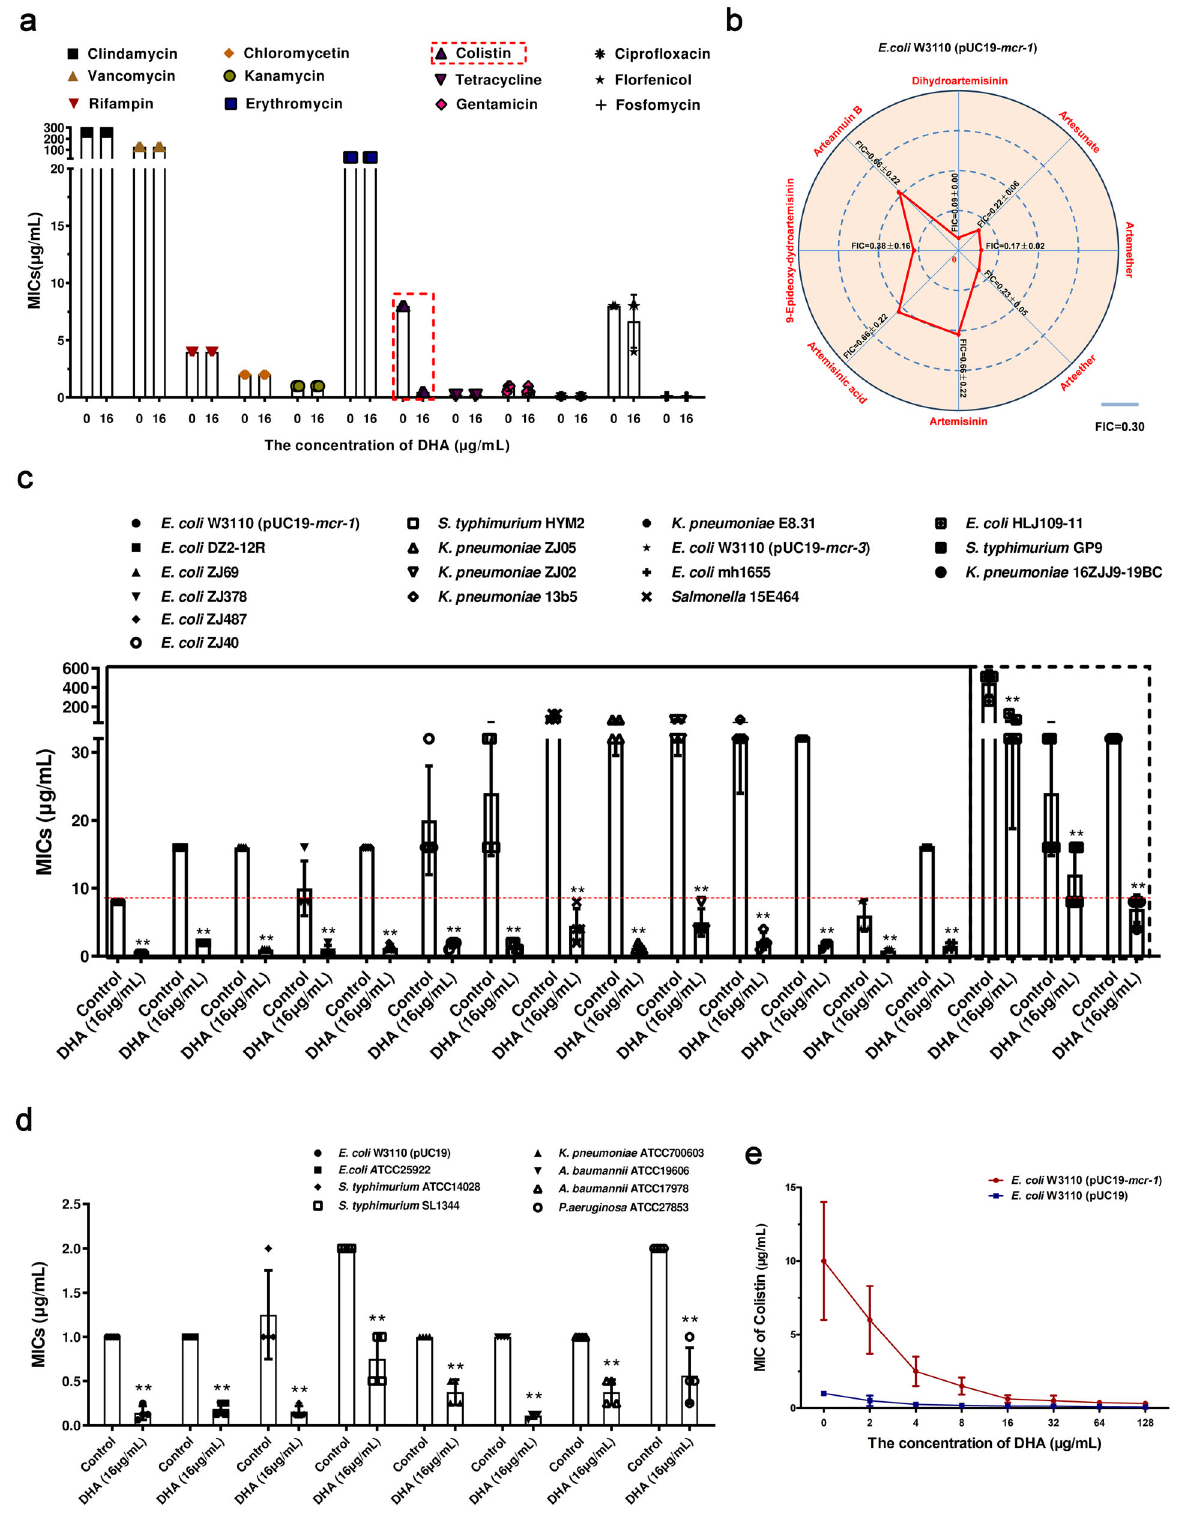
Fig. 1 DHA restores the antibacterial activity of colistin. a DHA (16 μ g/mL) only had a signi fi cant synergistic effect with colistin (outlined in red) among 12 different antibiotics against E. coli W3110 (pUC19- mcr-1 ) ( n = 3). b Contribution capacity chart of FIC showing that artemisinin derivatives such as artesunate, artemether, arteether and 9-epideoxy-dydroartemisinin also had a signi fi cant synergistic effect with colistin against E. coli W3110 (pUC19- mcr-1 ) ( n = 4). c – e DHA restored the antibacterial activity of colistin against MCR-positive bacteria (outlined in solid), MCR-negative polymyxin- resistant bacteria (outlined in dashed) and polymyxin-sensitive bacteria. MICs of colistin without DHA for all the tested bacteria was used as control. Data are representative of four independent experiments. ** P < 0.01.